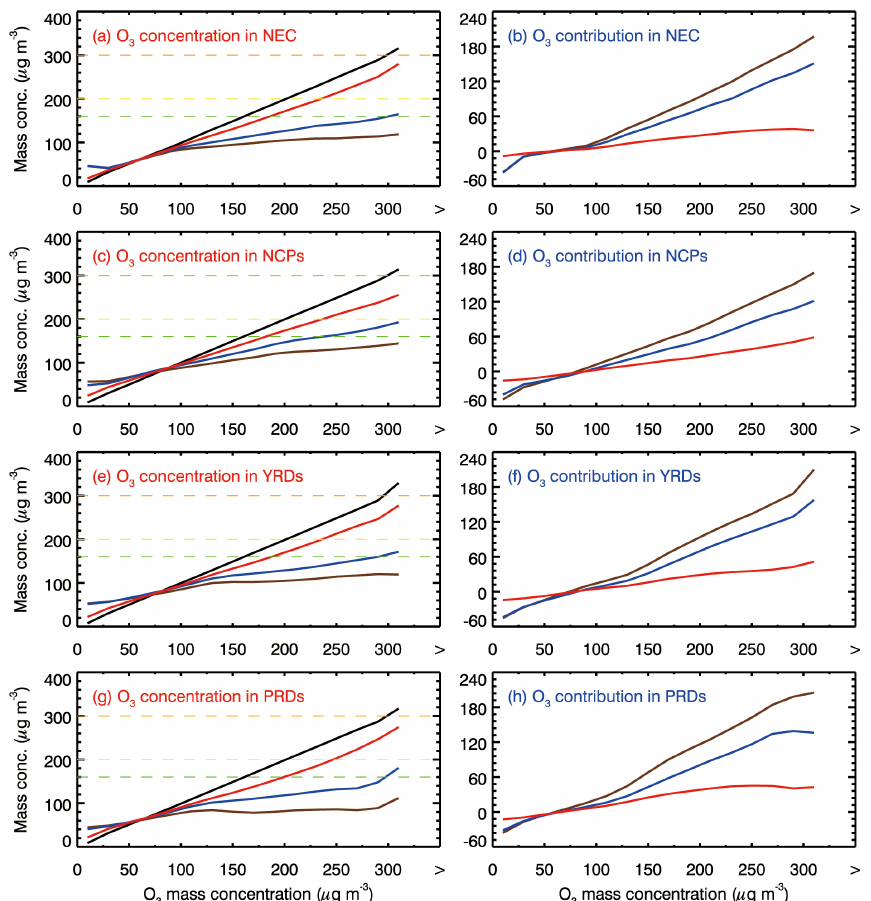
Figure 10. O 3 contributions when only the industry (red line), residential (brown line), and transportation emissions (blue line) are considered in NEC, NCPs, YRDs, and PRDs, as a function of simulated [O 3 ] in the control